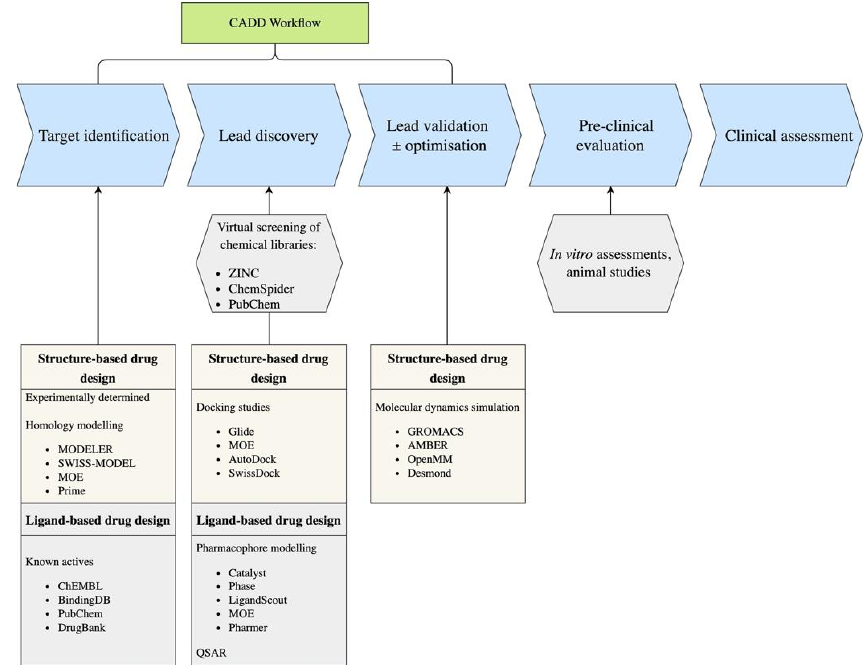
Figure 1. A drug design workflow including the stages of CADD. Both structure- and ligand-based applications are outlined. A sample of chemical libraries and software applications used in the different stages of the workflow are highlighted. It must be noted that these lists are not exhaustive and other libraries and software applications are available for use.